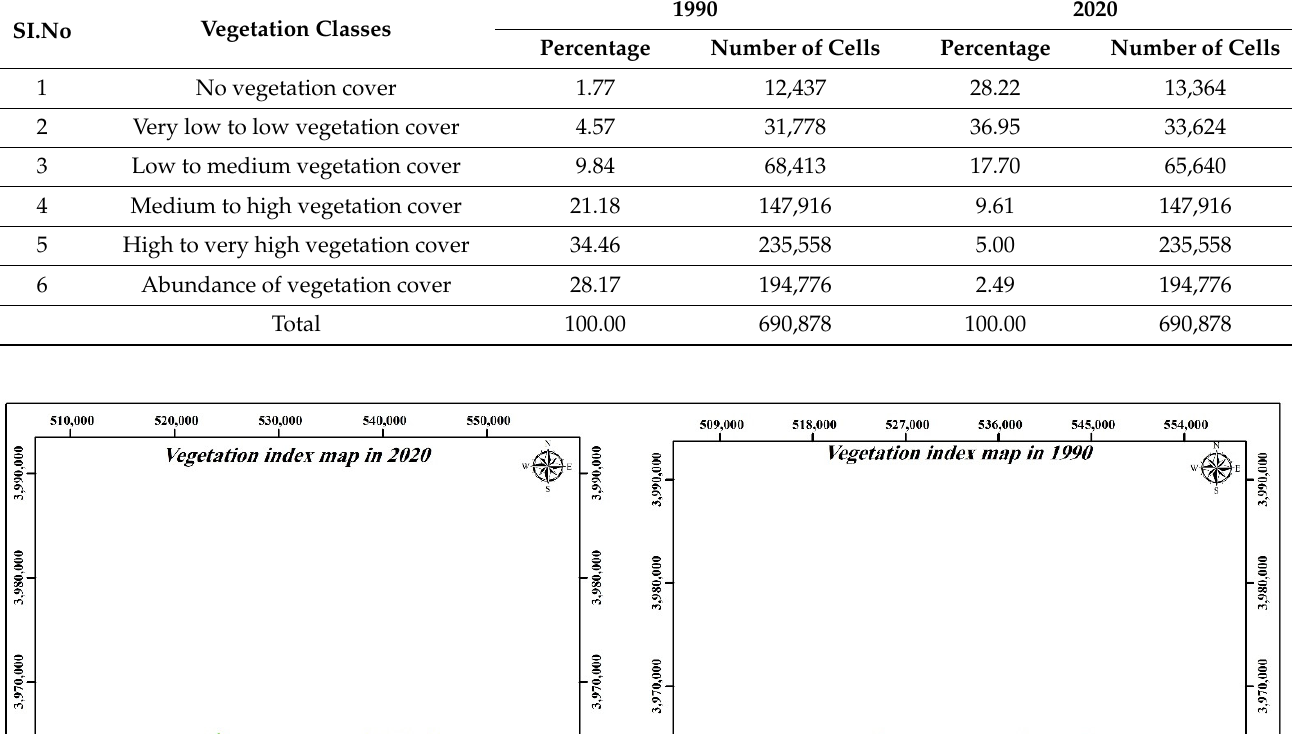
Table 2. The portion and percentage of vegetation index classes in the Tehran metropolis, 1990 and